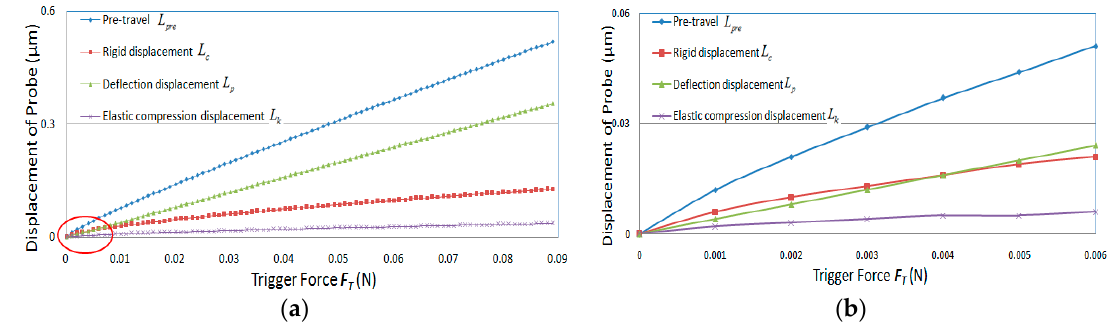
Figure 6. Simulation diagram of pre-travel and its components changing with trigger force. ( a ) various displacement changes in the whole trigger force range; ( b ) enlarged view of the red marked area in Figure 6a.